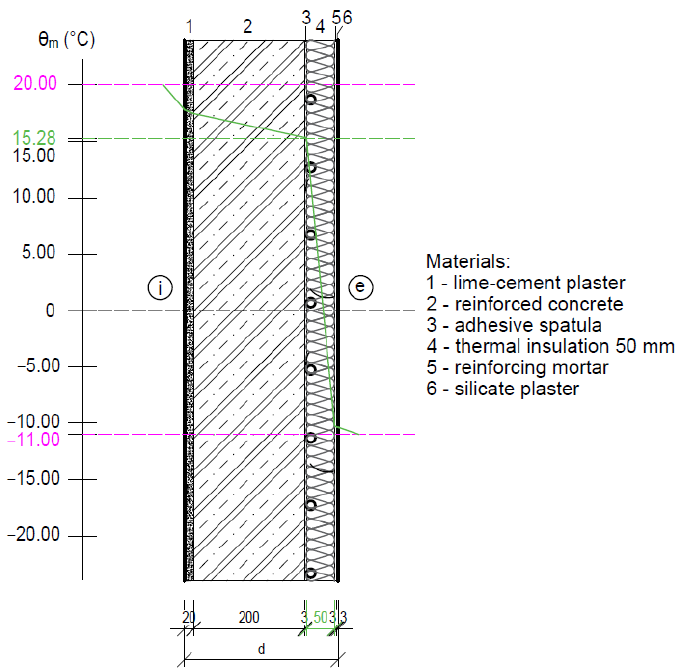
Figure 17. Reinforced concrete wall 200 mm thick with thermal insulation 50 mm thick on the outside. θ m —the temperature in construction ( ◦ C), d—construction thickness (mm), e—exterior, and i—interior.